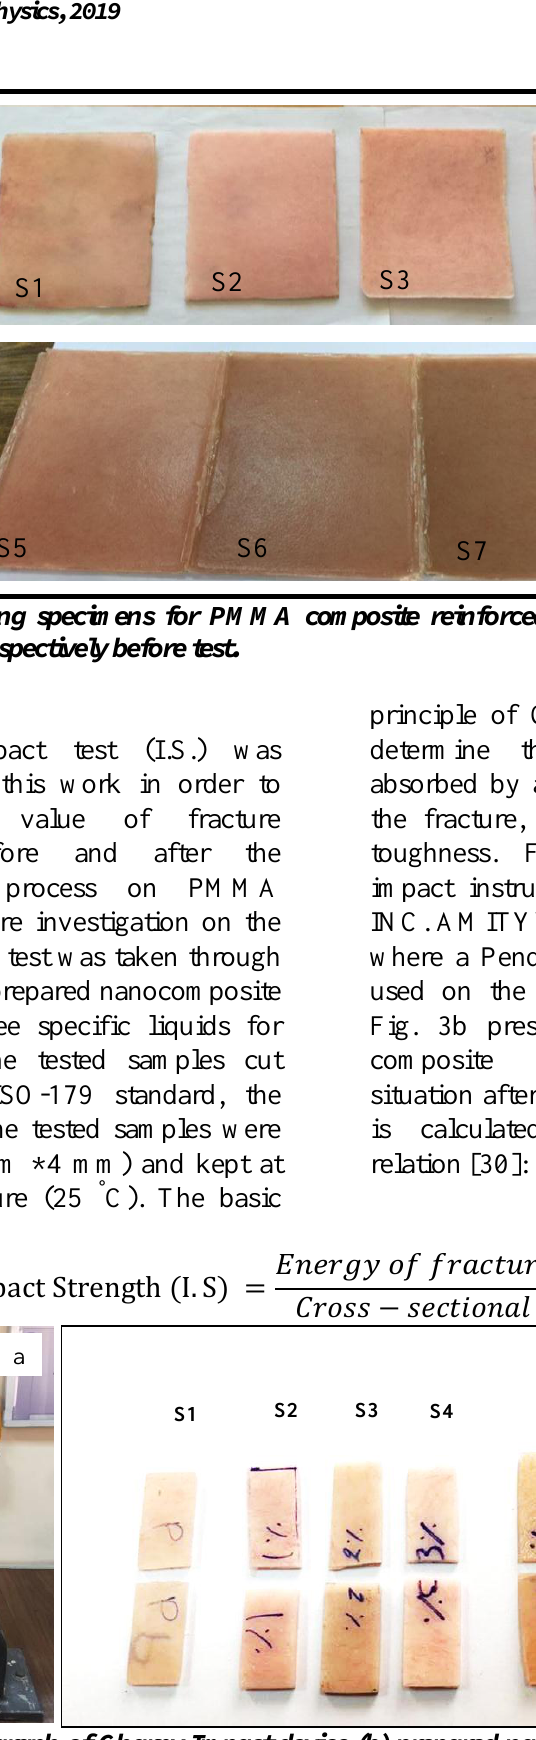
Fig.3: (a) Photograph of Charpy Impact device (b) prepared nano-composite samples after